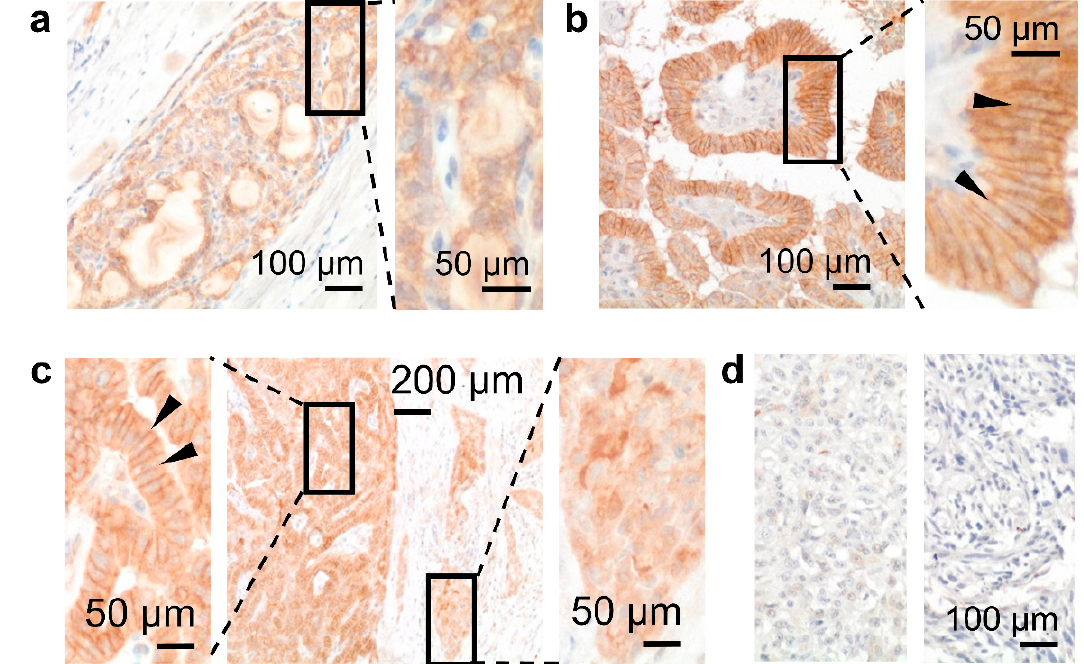
Figure 5. GPR56 localization changed during thyroid tumorigenesis. ( a ) In a follicular carcinoma, GPR56 is located mainly intracellularly as in normal thyrocytes. ( b , c ) In papillary carcinomas, GPR56 was strongly upregulated in lateral tumor cell contacts (inserts, arrowheads). Interestingly, at the invasion front GPR56 vanished (( c ), right insert) and tumor cells located in the invaded capsule showed no membranous staining. ( d ) In a poorly differentiated (left) and in an anaplastic carcinoma (right) GPR56 was strongly downregulated or even disappeared, respectively.